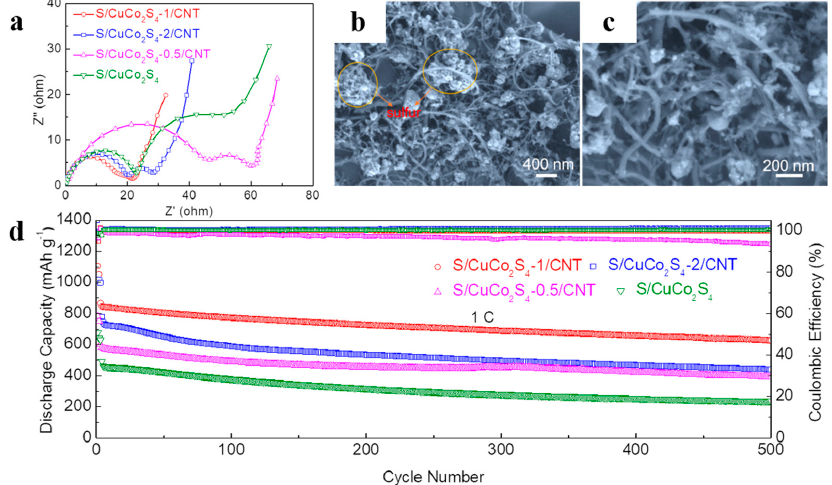
Figure 6. ( a ) Nyquist plots of S/CuCo 2 S 4 , S/CuCo 2 S 4 -0.5/CNT, S/CuCo 2 S 4 -1/CNT and S/CuCo 2 S 4 - 2/CNT cathodes after 100 cycles. ( b , c ) SEM image of S/CuCo 2 S 4 -1/CNT cathodes after charge–discharge cycle at 0.2 C. ( d ) Cycling performances of S/CuCo 2 S 4 , S/CuCo 2 S 4 -0.5/CNT, S/CuCo 2 S 4 -1/CNT and S/CuCo 2 S 4 -2/CNT cathodes at 1 C.